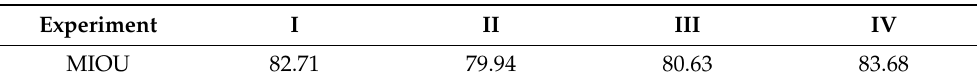
Table 6. Feature fusion MIOU comparison of different semantic segmentation networks on SIFT Flow dataset.